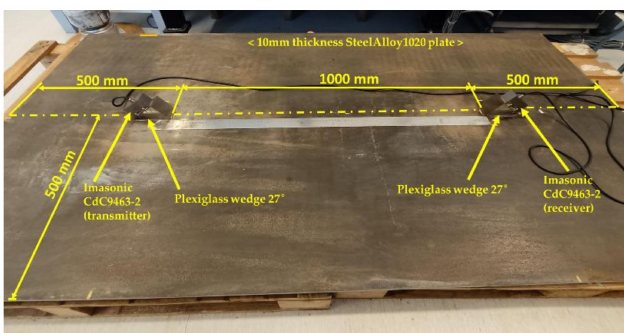
Figure 13. Photo of the experimental S 3 guided wave excitation in a 10 mm steel plate.